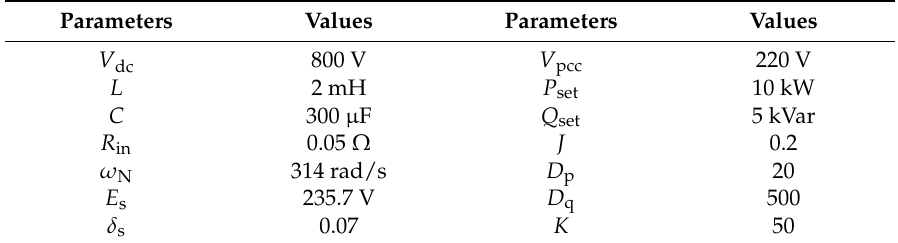
Table 1. Electrical and control parameters.